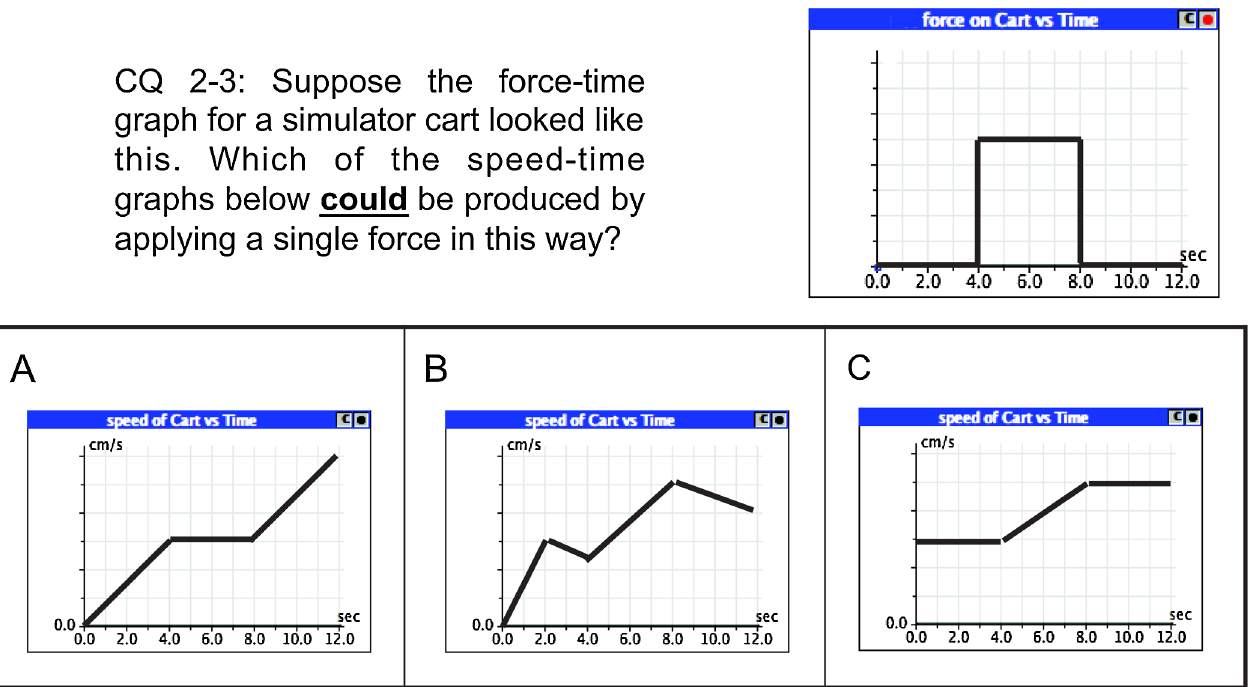
FIG. 11. Third clicker question in